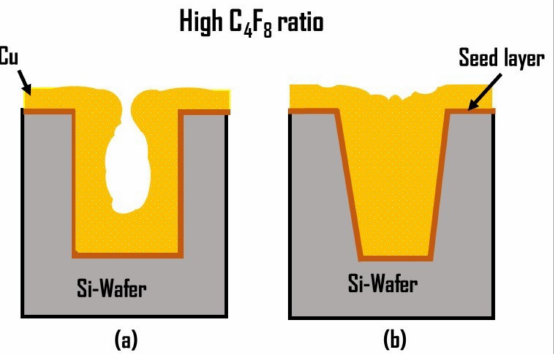
Figure 6. Schematic illustration of TSV shapes: ( a ) vertical shape; ( b ) inverted trapezoidal